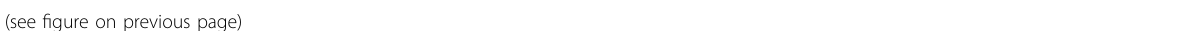
(see fi gure on previous page) Fig. 5 CRO15 mediates the activation of autophagy and apoptosis in melanoma cells. A A375 cells were treated with 5 μ M CRO15 for the indicated duration. Lysates were analyzed by western blotting with the indicated antibodies. One representative experiment of three is shown. B Immuno fl uorescence pictures of A375 melanoma cells treated with DMSO, 5 μ M CRO15 or 400 nM of the autophagy inducer rapamycin for 6 h. LC3B was labeled with antibody (green), and DNA was visualized with DAPI (blue). C A375 melanoma cells were treated for 24 h with 5 μ M CRO15, 5 μ M PLX4032 or with 1 μ M of the pan-kinase inhibitor staurosporine for 6 h used as positive control of apoptosis induction. Cells were analyzed by fl ow cytometry using a speci fi c antibody against Caspase 3 active protein conjugated with FITC (upper panel) or Annexin V conjugated with ALEXA and DAPI (lower panel) or against. * p < 0.05; ** p < 0.01; *** p < 0.001. D A375 cells were infected with dominant negative adenoviruses against α 1 and α 2 AMPK subunits for 24 h before transfection with sip53 for another 24 h. Cells was determined by trypan blue staining after a 24 h treatment with 5 μ M CRO15 or DMSO control. E A375 cells were infected with dominant negative adenoviruses against α 1 and α 2 AMPK subunits for 24 h and were transfected with sip53 for another 24 h. Cells were treated with 5 μ M CRO15 for the indicated durations, and lysates were analyzed by western blot with the indicated antibodies. One experiment of three is shown. F A375 cells were treated with 5 μ M CRO15 for the indicated durations, and lysates were analyzed by western blotting with the indicated antibodies. One representative experiment of three is shown. G A375 cells were transfected with siREDD1 for 24 h and then treated with 5 μ M CRO15 for 24 h before cell viability was determined using the trypan blue exclusion method. H . A375 cells were transfected with siREDD1 for 24 h and then treated with 5 μ M CRO15 for the indicated duration. Lysates were analyzed by western blotting with the indicated antibodies. One representative experiment of three is shown. For D and G , the results are expressed as percentages of the control and data given as the means ± SEM of three independent experiments performed in triplicate. * p < 0.05; ** p < 0.01; *** p <